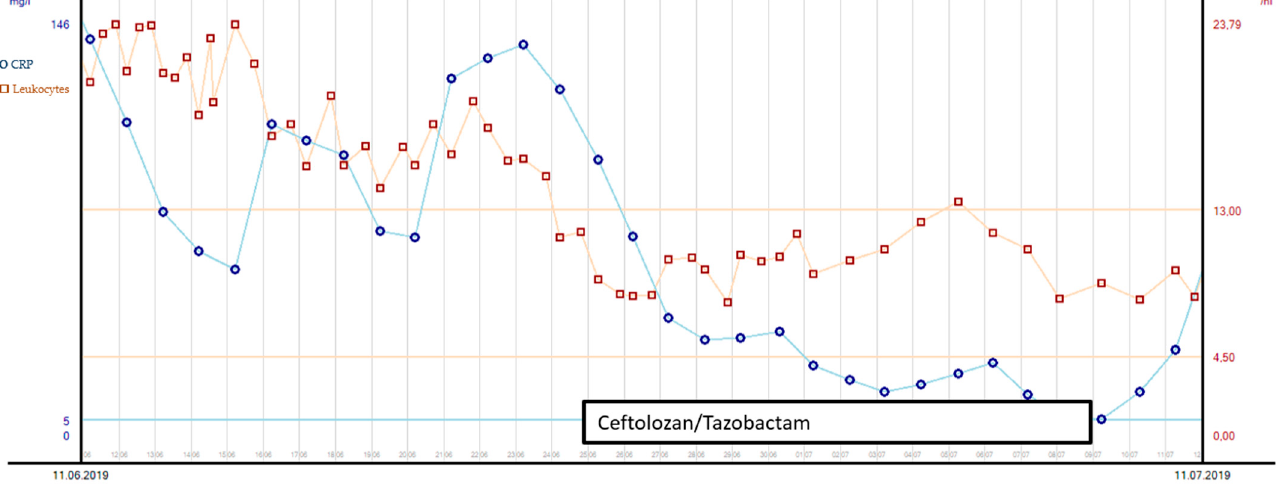
Figure 3. Leucocyte count and CRP course with corresponding antibiotic treatment during days 31 and 60 after ICU admission.